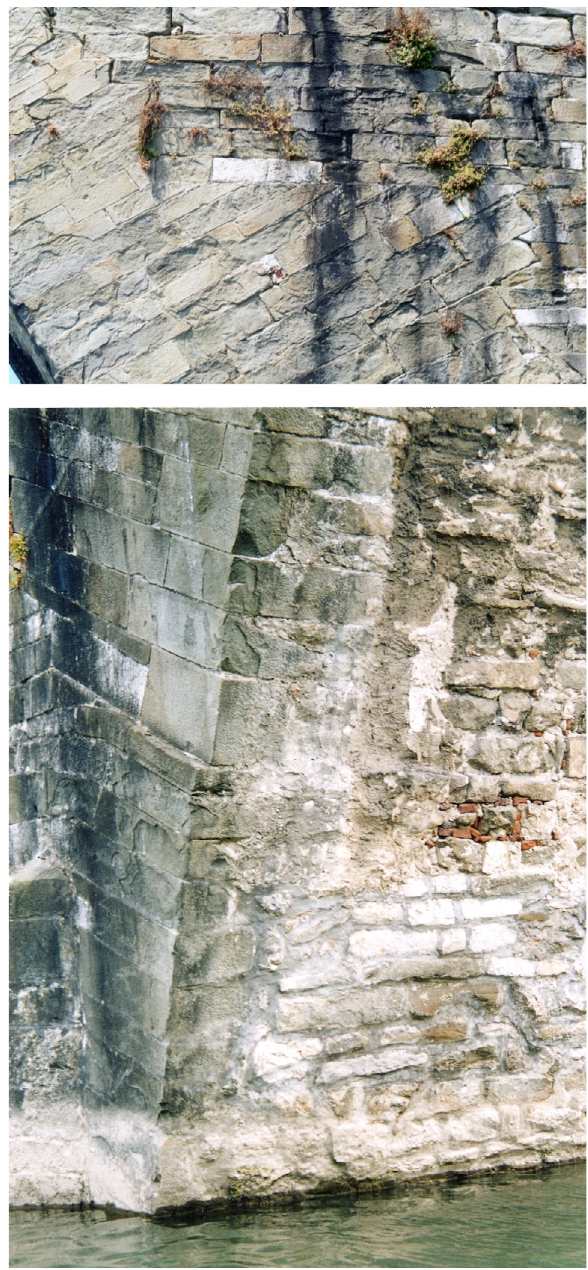
Figure 3. Detail of the masonry texture on the main arch: at the left haunch on the downstream side (top) and at the left springer on the upstream side